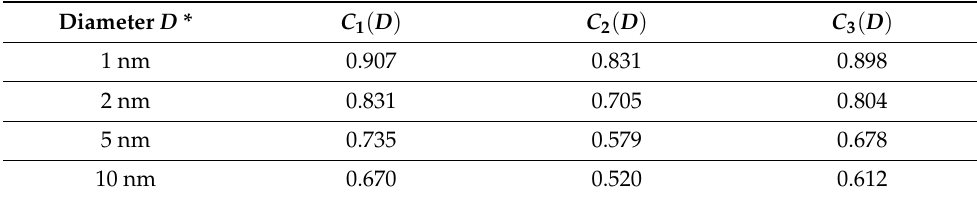
Table 1. The parameters C k ( D ) of the fitting functions given in Equations (3)–(5) for the different site sizes.